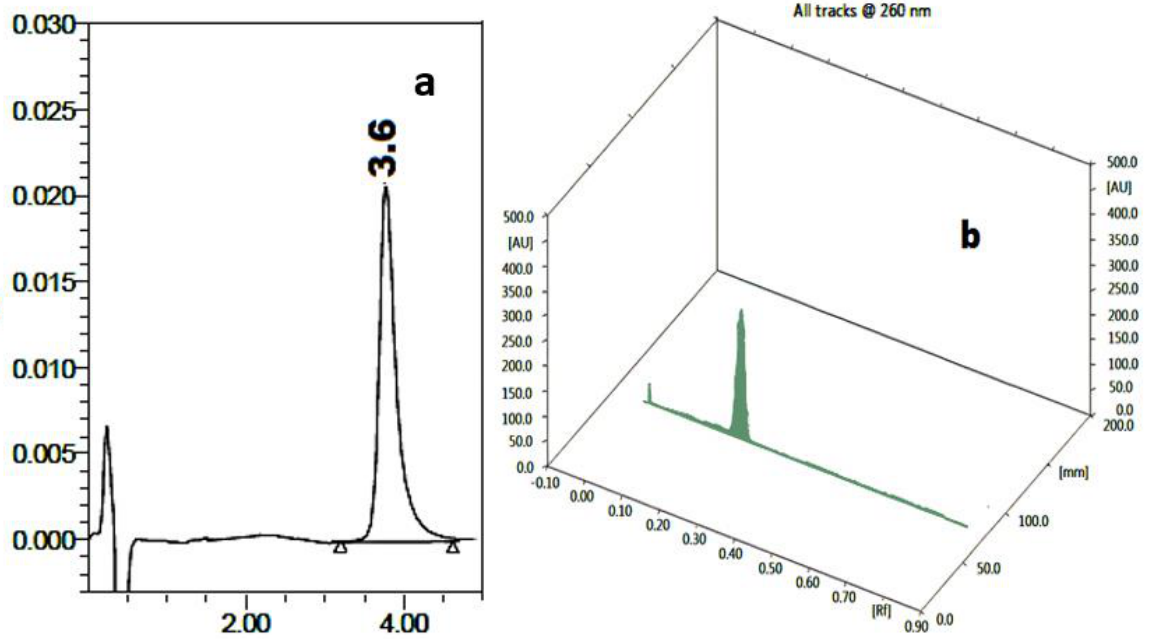
Figure 3. Chromatograms showing the application of the proposed methods for the determination of BHS in Betaserc ® tablets, where ( a ) HPLC (BHS; 5.0 µg mL − 1 ) and ( b ) HPTLC (BHS; 5000.0 ng per band).